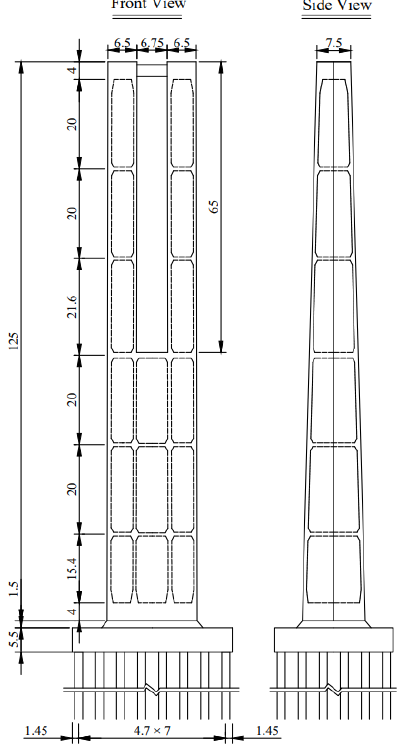
Figure 2. Front and side design drawings of Pier 8# (m).